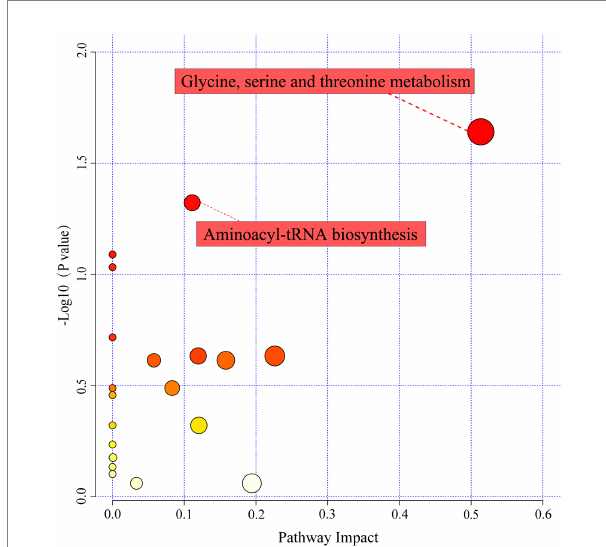
FIGURE 6 Influencing factors of metabolic pathways. A larger circle means a larger impact factor, and vice versa a smaller impact factor. The redder the color of the circle, the smaller the p -value.